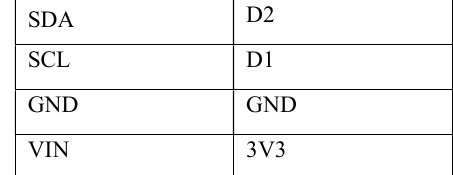
Table 4. Pin Configuration between node MCU and